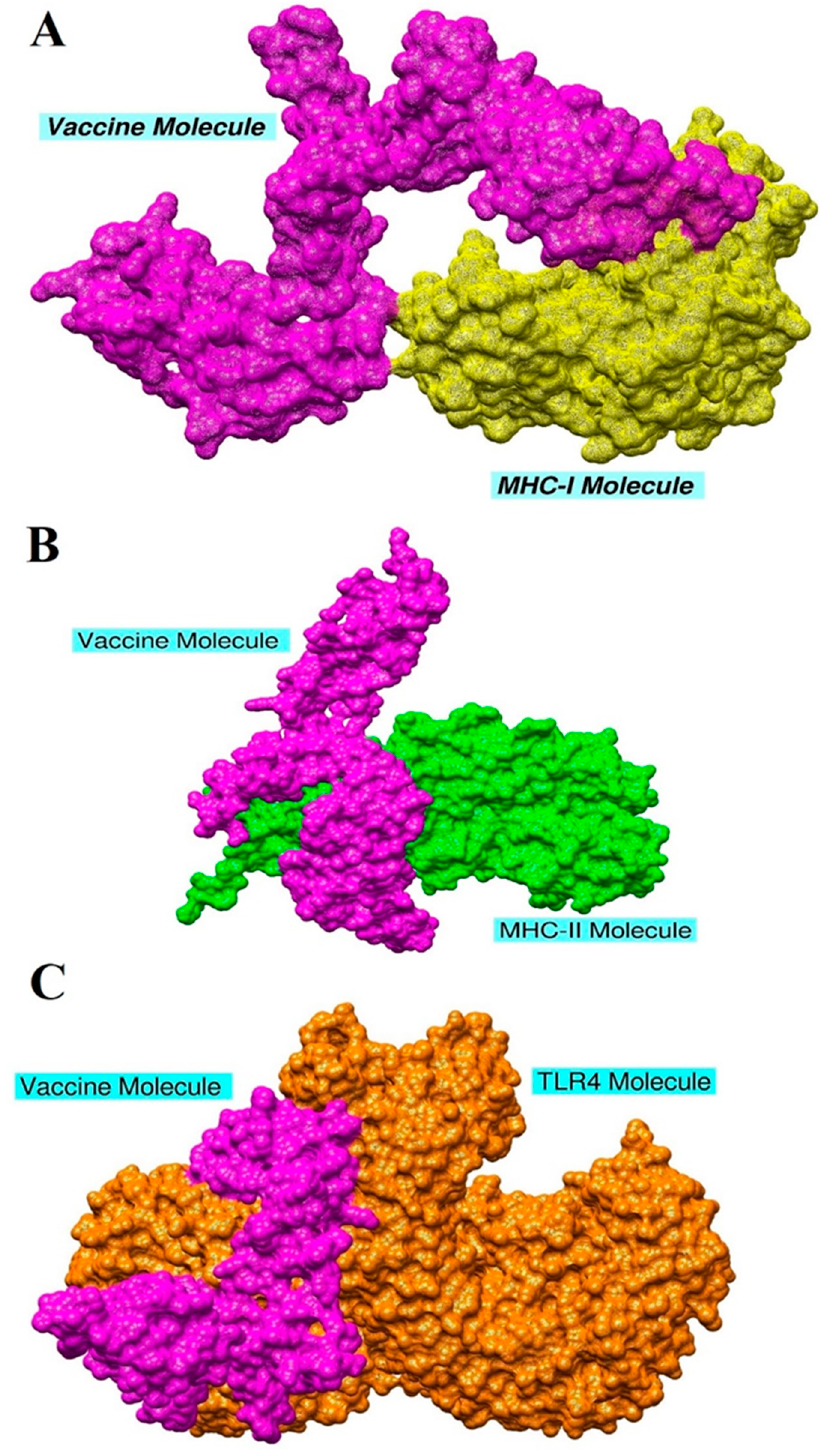
Figure 8. Docked vaccine structure to the MHC-I molecule ( A ), MHC-II molecule ( B ), and TLR4 molecule ( C ).